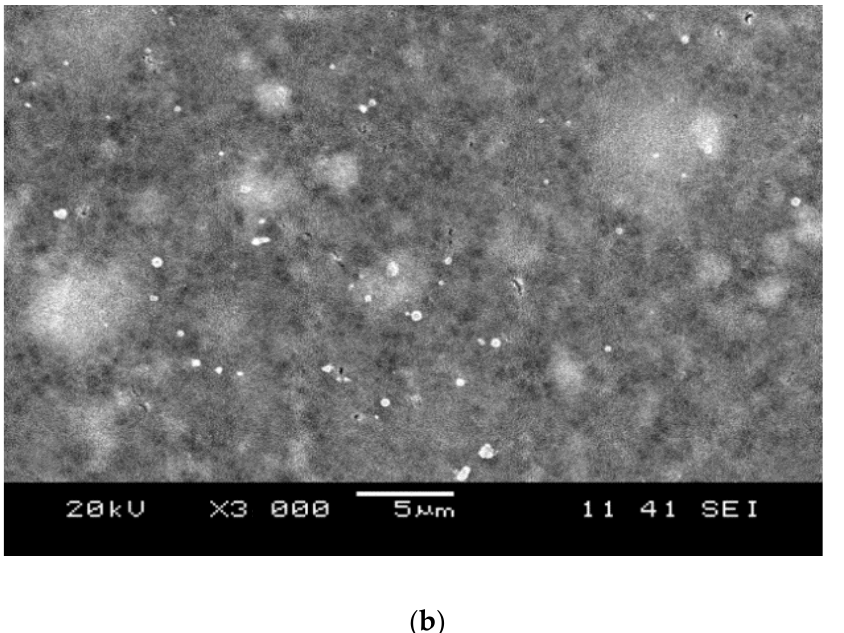
Figure 4. ( a ) Top view SEM images of a neat PES membrane; and ( b ) top view SEM images of the TiO 2 /PES mixed matrix membrane.